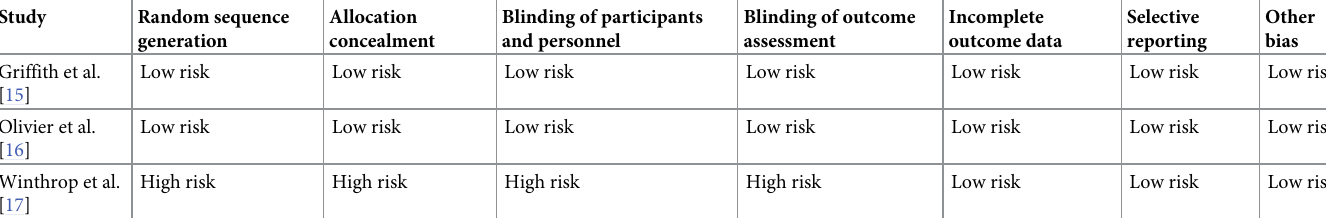
Table 4. Quality assessment of the experimental studies by the Cochrane collaboration tool.